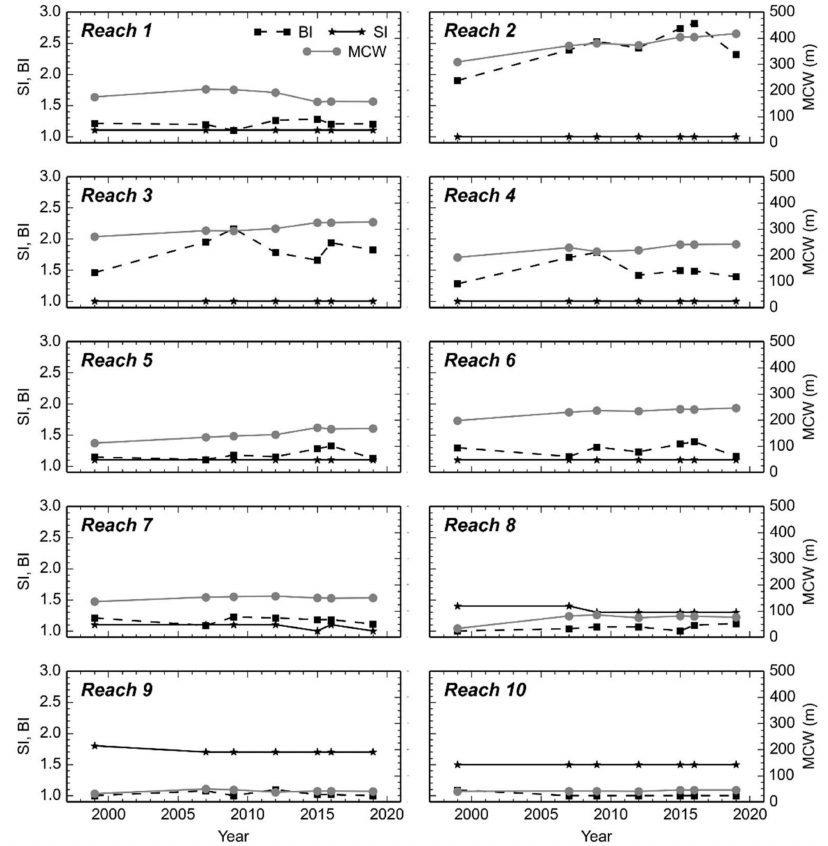
Figure 4. Variation of sinuosity index (SI), braiding index (BI) and mean active-channel width (MCW) over time at reach scale. SI and BI are dimensionless